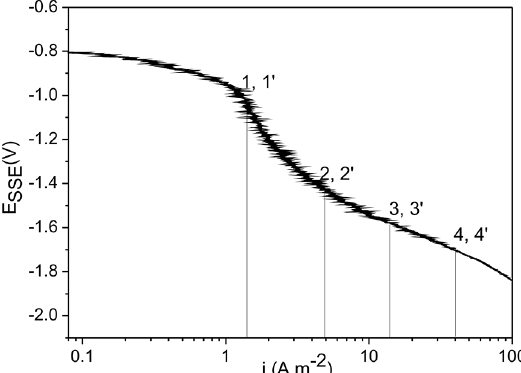
Figure 3. Cathodic polarization curves of the steel substrate in the electrolytic bath composed by 0.02 mol L -1 CuSO CoSO .7H O and 0.50 mol L -1 sodium tartrate Na2C4H4O6.4H2O. 4 2 1/1’, 2/2’, 3/3’ and 4/4’ refer to the electrodeposition